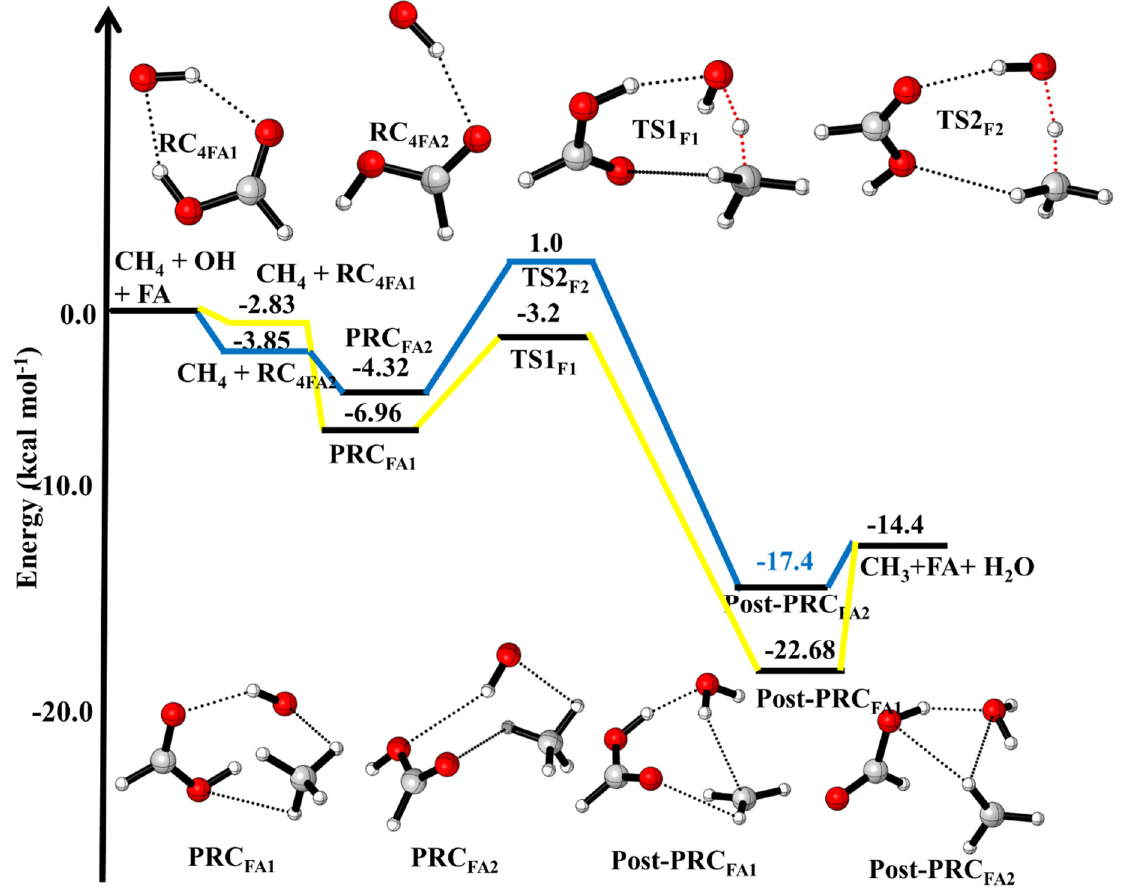
Figure 2. Potential-energy surface for the effect of FA on · OH + CH 4 reaction leading to form methyl radical, water, and formic acid. The stationary point was computed at the CC//M06-2X level and ZPE correction obtained from vibrational analysis using M06-2X.